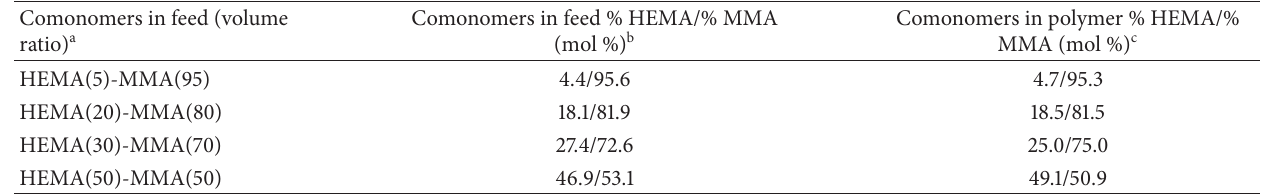
Table 2: Compositions of P(HEMA- co -MMA) obtained from 1 H-NMR data.